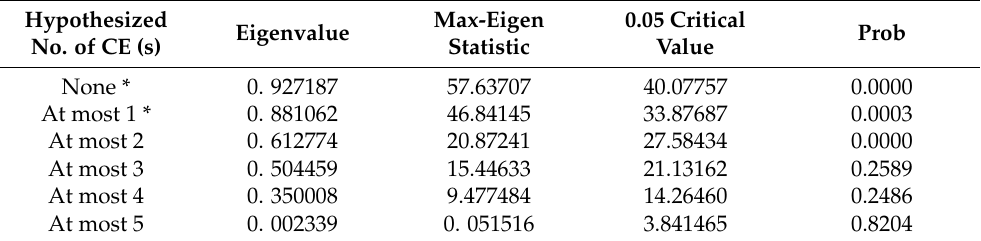
Table A4. Johansen Unrestricted Cointegration Rank Test (Maximum Eigenvalue).